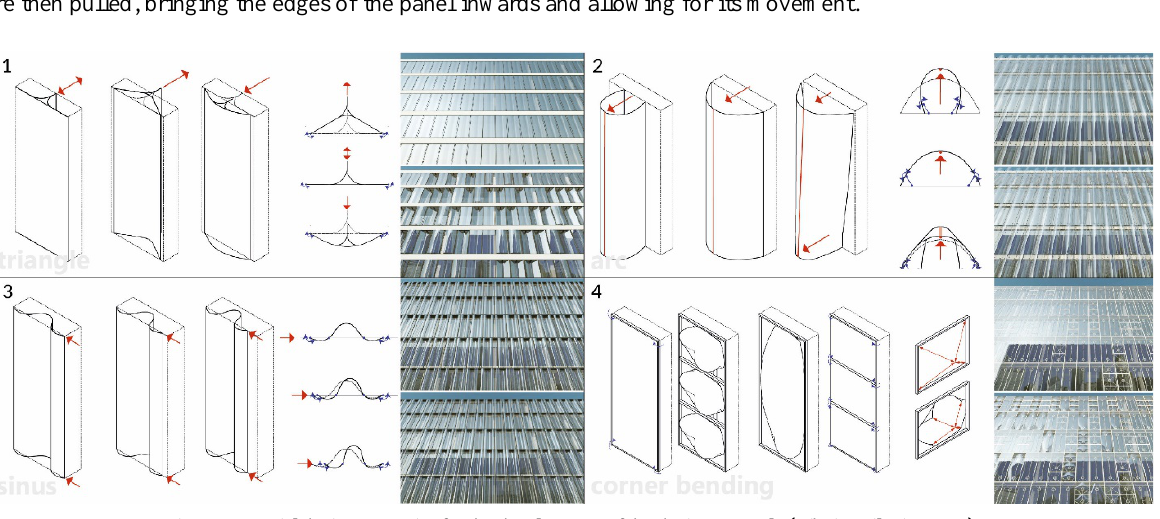
Fig. 10 Potential design strategies for the development of the design example (Ribeiro Silveira